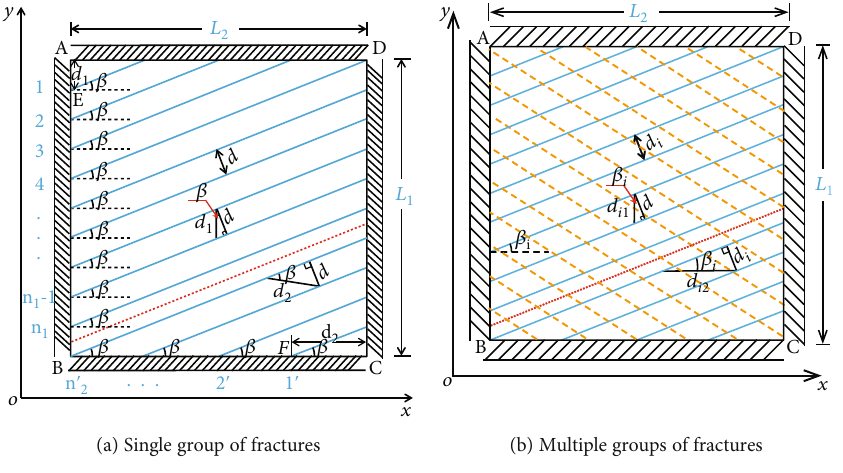
(b) Multiple groups of fractures Figure 3: Schematic diagram of fracture networks.